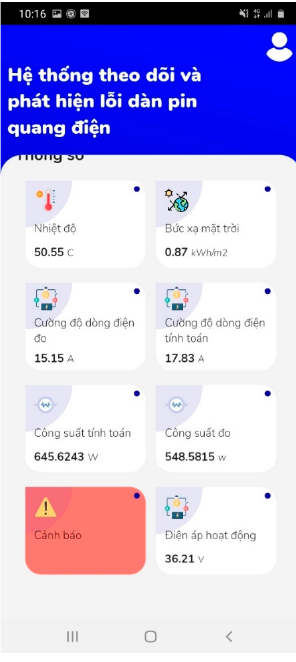
Figure 10. Screenshop of Android app for warning.